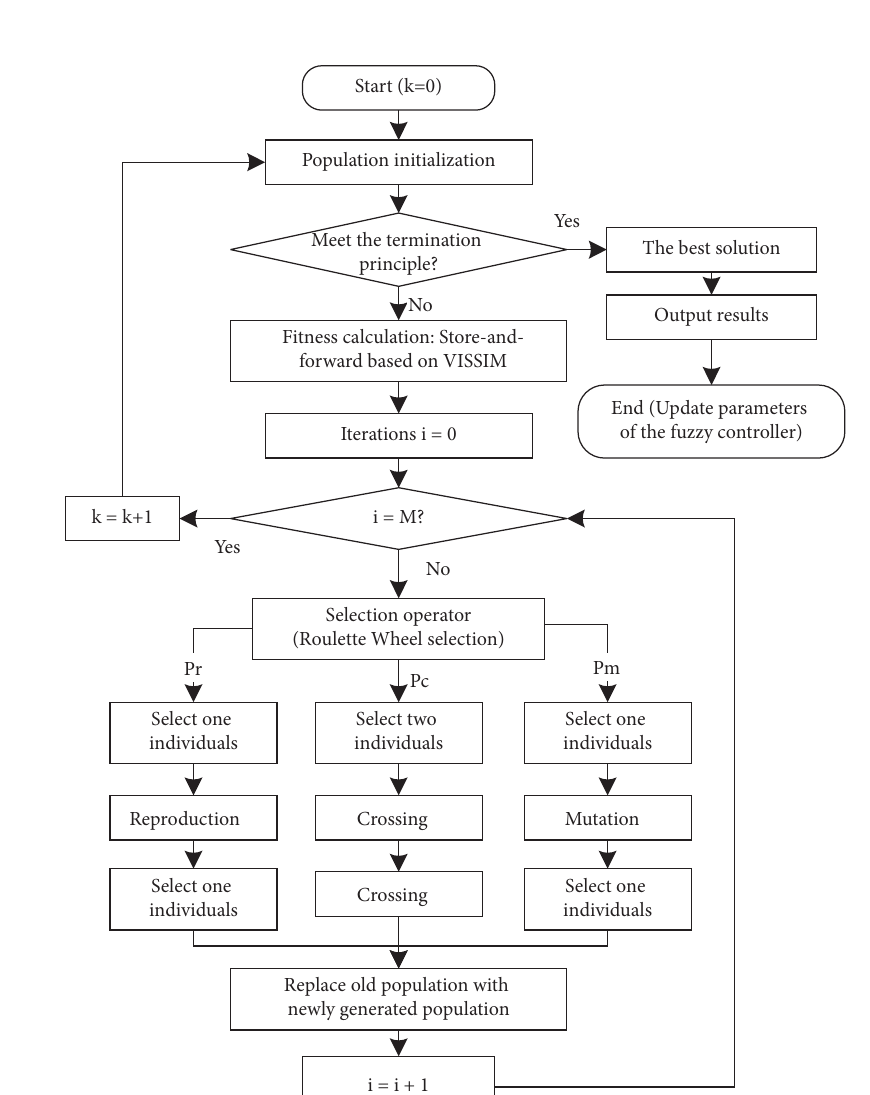
Figure 3: Framework of the parameter optimization module.